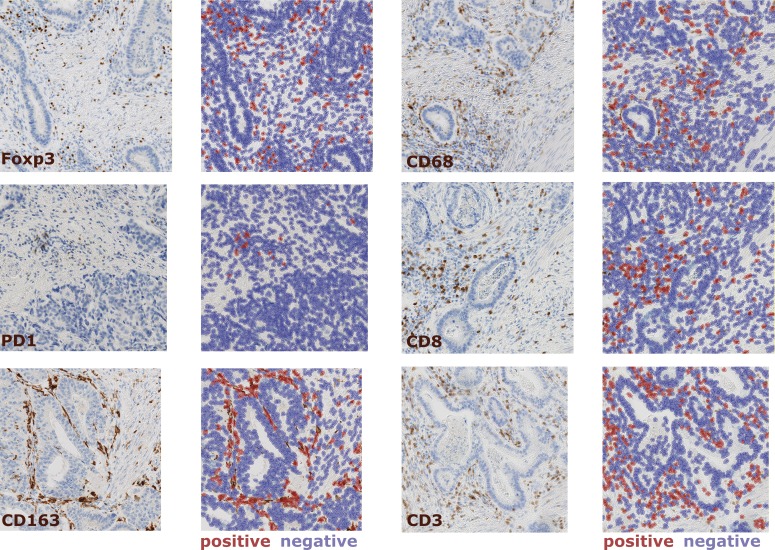
Example images for cell count in all six immunostains.For all slides with sufficient sample availability, we performed immunostaining for Foxp3, CD68, PD1, CD8, CD163 and CD3. QuPath was used for automatic cell detection and classification. Here, example images are shown for each staining type (20x magnification) along with the result of the cell segmentation.